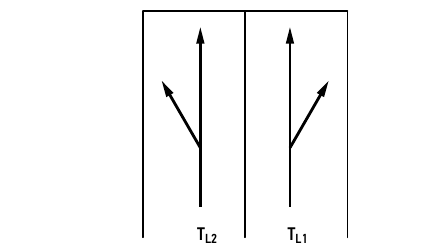
Fig. 3. Scheme for calculation of the capacity of mixed traffic